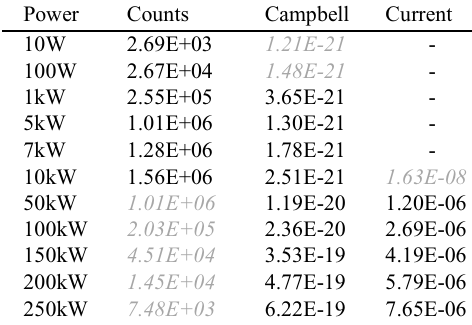
The two FCs were also used to check the linearity of the three operating modes independently. The operators stabilized the reactor power at different power steps from 10W to 250kW (reactor nominal power). At each power step, MONACO v2 measurements were averaged over 60